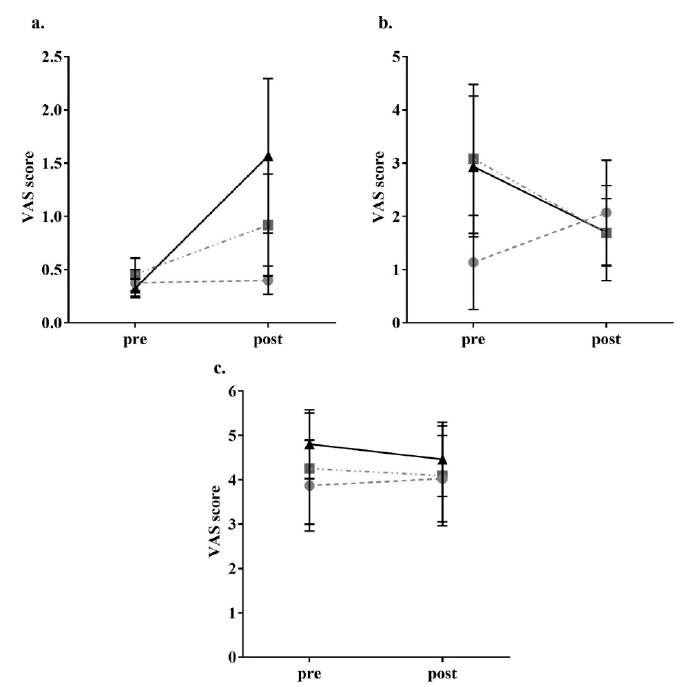
Figure 3. Participant visual analogue scale other sensations responses. ( a ) Anxiety; ( b ) Nausea; ( c ) Fatigue.